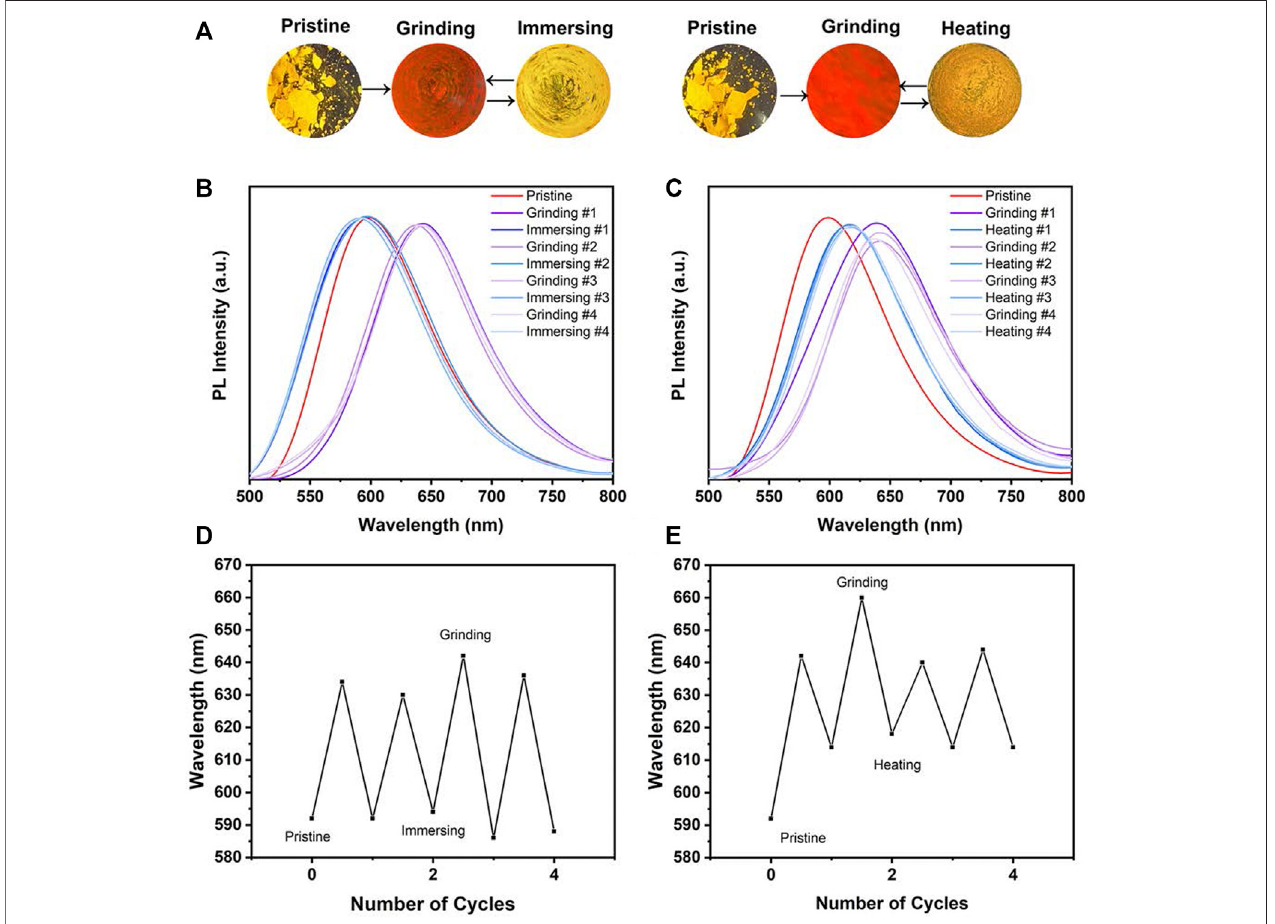
FIGURE6|(A) PLspectraof MOX2 powderunderalternatinggrinding,immersingandheating;Imagesweretakenundera365 nmhand-heldUVlamp.Changein the PL spectrum of MOX2 in grinding-immersing (B) and grinding-heating (D) circles. Repeated switching of the emission wavelength in grinding-immersing (C) and grinding-heating (E) circles.